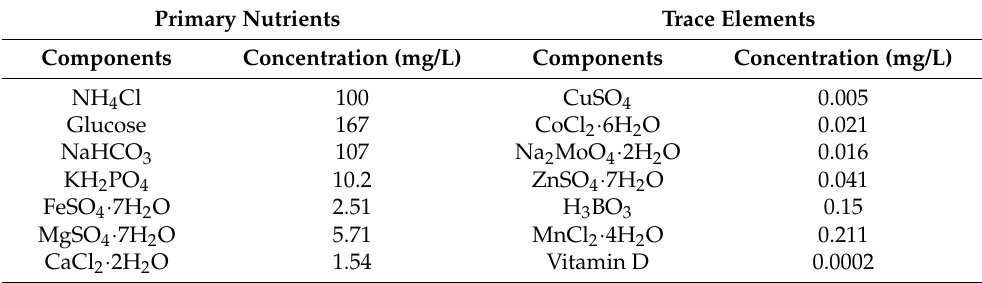
Table 1. Components of synthetic wastewater.